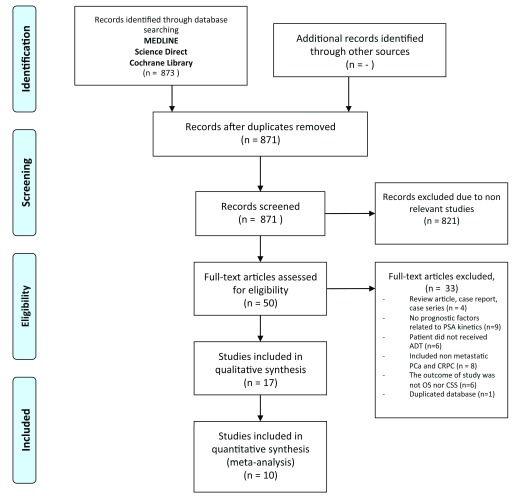
Flowchart showing the searching strategy of the studies.